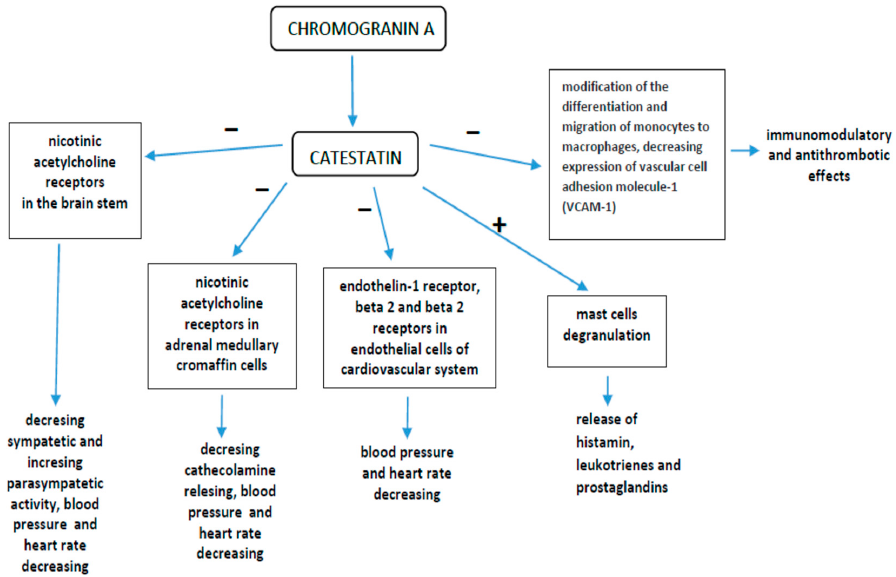
Figure 1. Catestatin mechanisms of action with clinical effects.